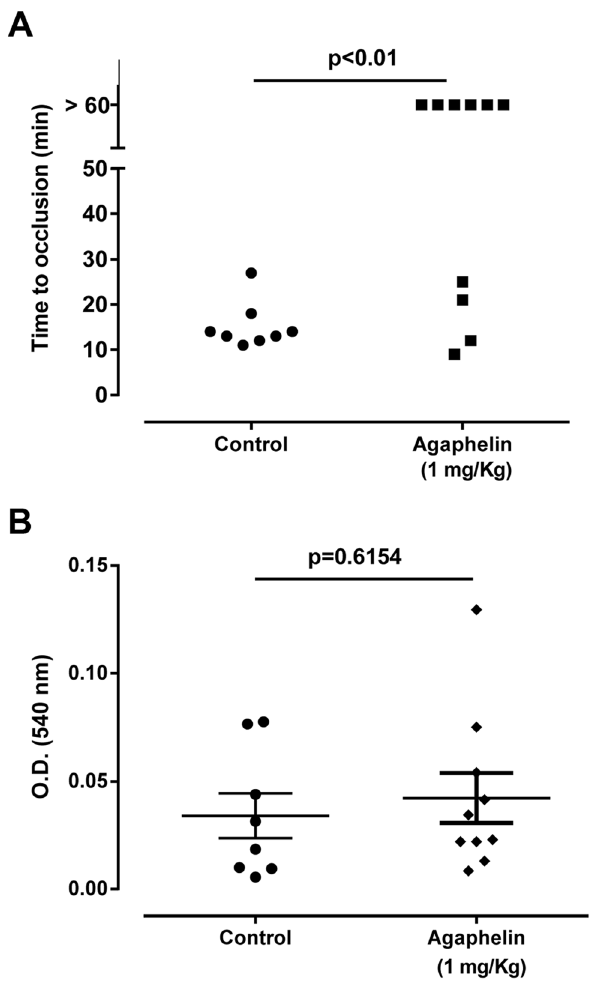
Figure 7. Agaphelin inhibits thrombosis in vivo , without impairing hemostasis. A) Arterial thrombosis. A paper filter infused with 7.5% FeCl 3 was applied to the carotid artery, and blood flow was monitored with a perivascular flow probe for 60 min or until stable occlusion took place. Fifteen minutes before injury, Agaphelin was injected into the caudal veins of the mice. Each symbol represents one animal. *, p , 0.05 (ANOVA with Dunnett post-test). B) Bleeding time. Bleeding was caused by a tail transection after intravenous injection of Agaphelin at the indicated concentrations. Absorbance at 540 nm (hemoglobin concentration) was used to estimate blood loss. *, p , 0.05 (ANOVA with Dunnett post-test).